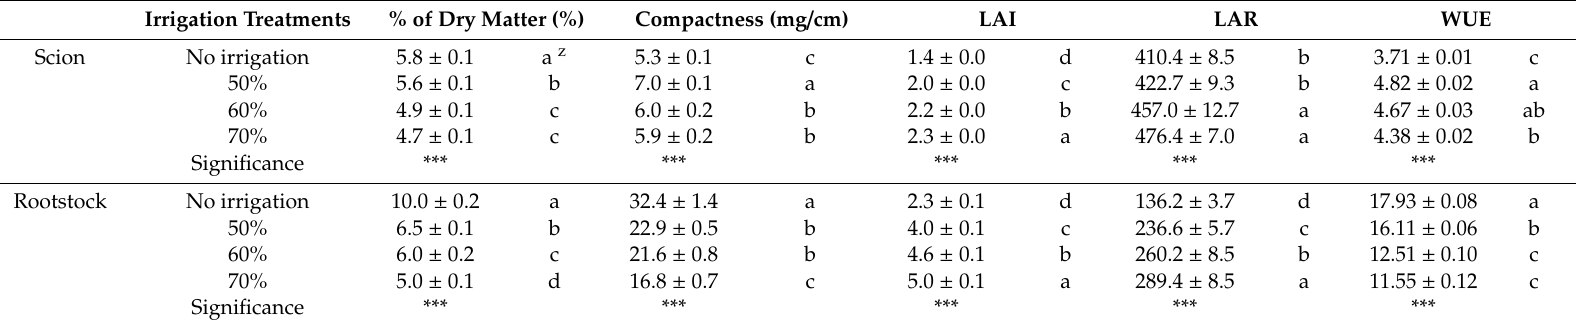
Table 2. The percentage of dry matter, compactness, leaf area index (LAI), leaf area ratio (LAR) and water use e ffi ciency (WUE) of cucumber scion and rootstock as a ff ected by di ff erent irrigation regimes during the cultivation in a PFAL ( n = 7, R =